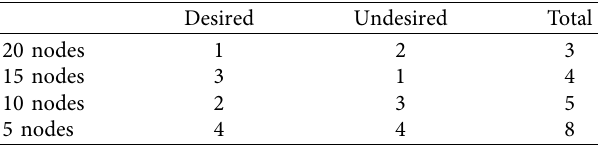
Table 13: Power performance ranking corresponding to null steering using 20, 15, 10, and 5 nodes.